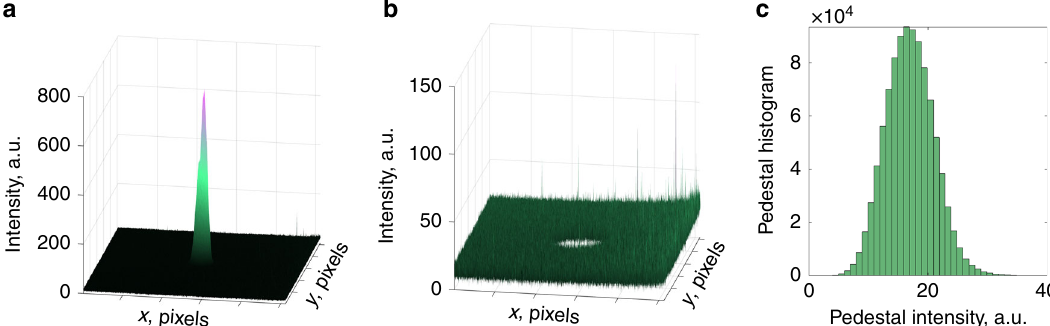
Fig. 8 Accounting for intensity pedestal and calculating noise from the experimental data. Figure shows a measured intensity pro fi le, b pedestal intensity distribution, and c histogram of the pedestal. Mean decomposition time is 63 µ s for 128 × 128 images. The measured SNR value is 23 dB.